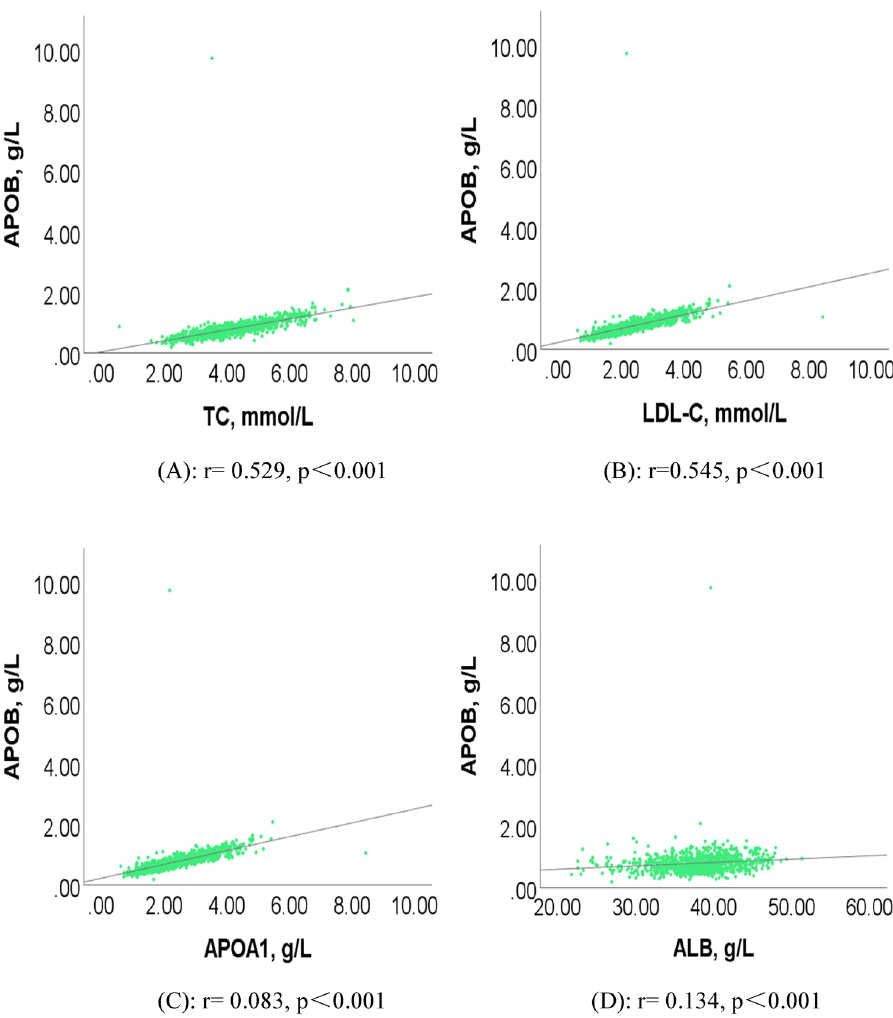
Figure 3. The related factors of APOB levels in AF patients. ( A ) Correlation between APOB and TC in AF group (r = 0.529, p < 0.001). ( B ) Correlation between APOB and LDL-C in AF group (r = 0.545, p < 0.001). ( C ) Correlation between APOB and APOA1 in AF group (r = 0.083, p < 0.001). ( D ) Correlation between APOB and ALB in AF group (r = 0.134, p < 0.001). Abbreviations as in Table 1. The figures were developed by SPSS software (version 26.0, SPSS Inc., Chicago, IL,